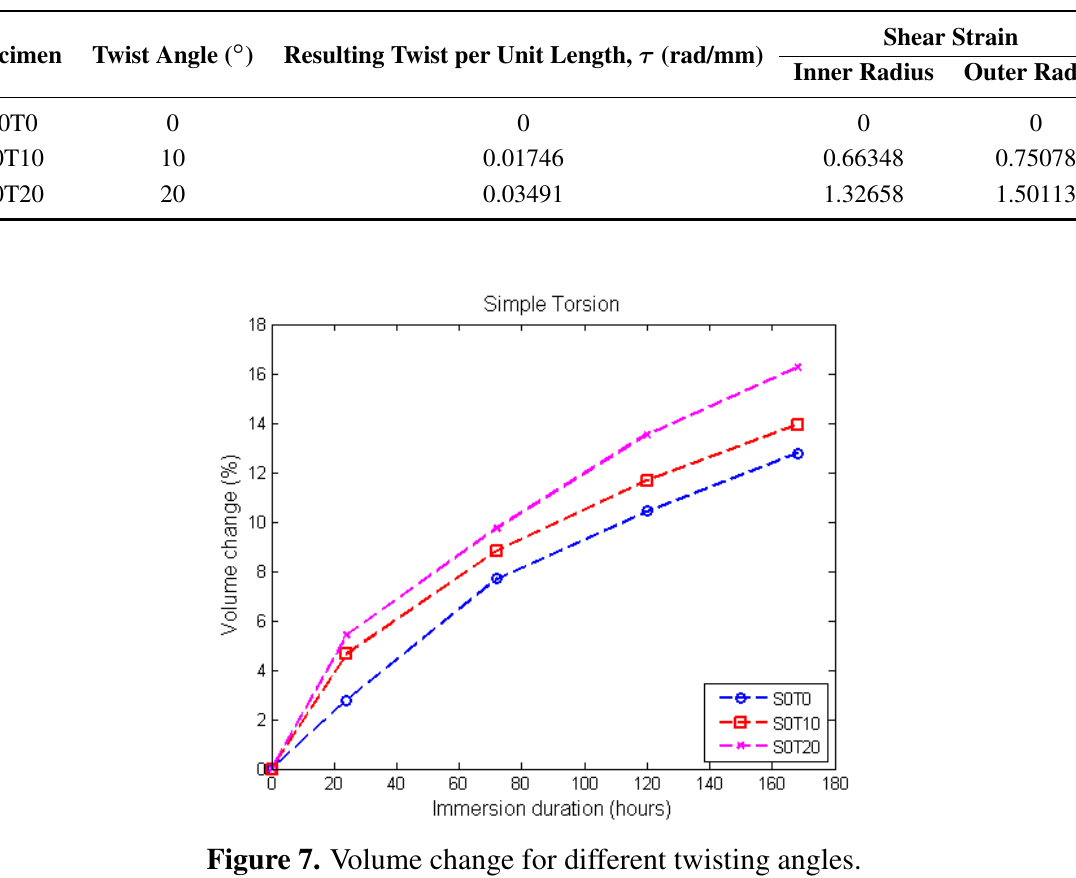
Table 1. Mechanical loading conditions.